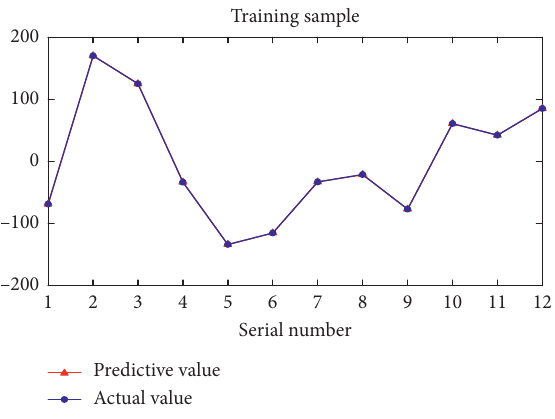
Figure 14: Residual training